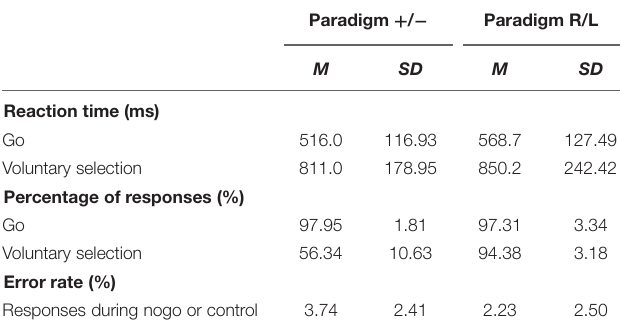
TABLE 1 | Behavioral data: the response times were significantly longer in voluntary selection trials than in go trials in paradigm + / − and paradigm